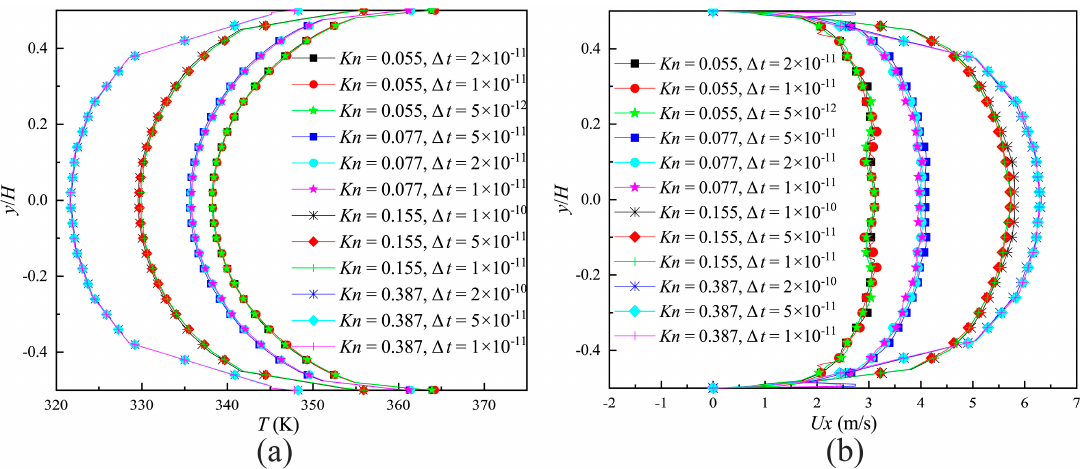
Figure 4. Calculation results of different time steps. ( a ) Velocity distributions on the outlet of the narrow channel; ( b ) temperature distributions on the outlet of the narrow channel. Table 1. The mass flow rate for different cell sizes and the numbers of the simulator in the cell, at the